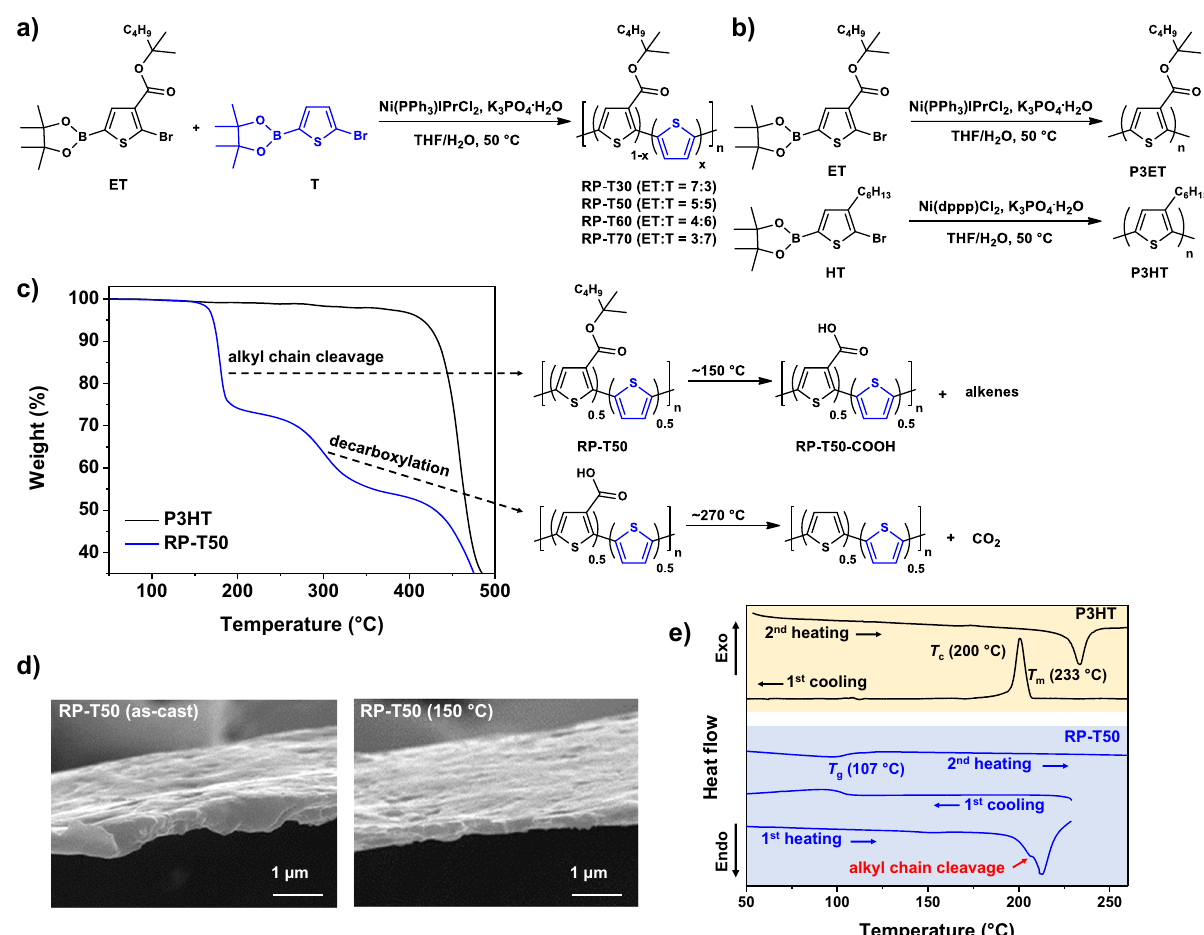
Fig. 1 Synthesis and characterization of polymers. Synthetic schemes for RP-T series ( a ), and P3ET and P3HT ( b ). c TGA thermograms of P3HT and RP- T50, and schemes of alkyl chain cleavage and decarboxylation of RP-T50. The alkyl chains decompose into alkenes and leave RP-T50-COOH behind after the alkyl chain cleavage. d SEM images of as-cast and 150 °C annealed RP-T50 fi lms. e DSC thermograms of P3HT and